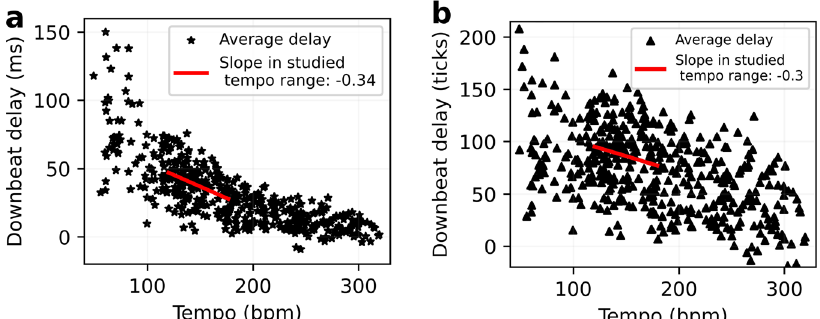
Fig. 1 Average downbeat delays of soloists as a function of tempo. Each point in the scatter plots corresponds to a piece of the Weimar Jazz Database 29 . In order to ease readibility, the corresponding standard deviations are shown in Supplementary Fig. 1. a Average downbeat delays in milliseconds as a function of tempo in beats per minute. The red line delimits the tempo range of pieces used in our experiment (see “ Methods ” section) and corresponds to the fi t in ( b ). The scattered data exhibit mostly positive delays with generally a nonlinear trend, which is nearly linear in this restricted tempo range. b Average downbeat delays expressed in ticks as a function of tempo. The red line shows a linear fi t to the data.